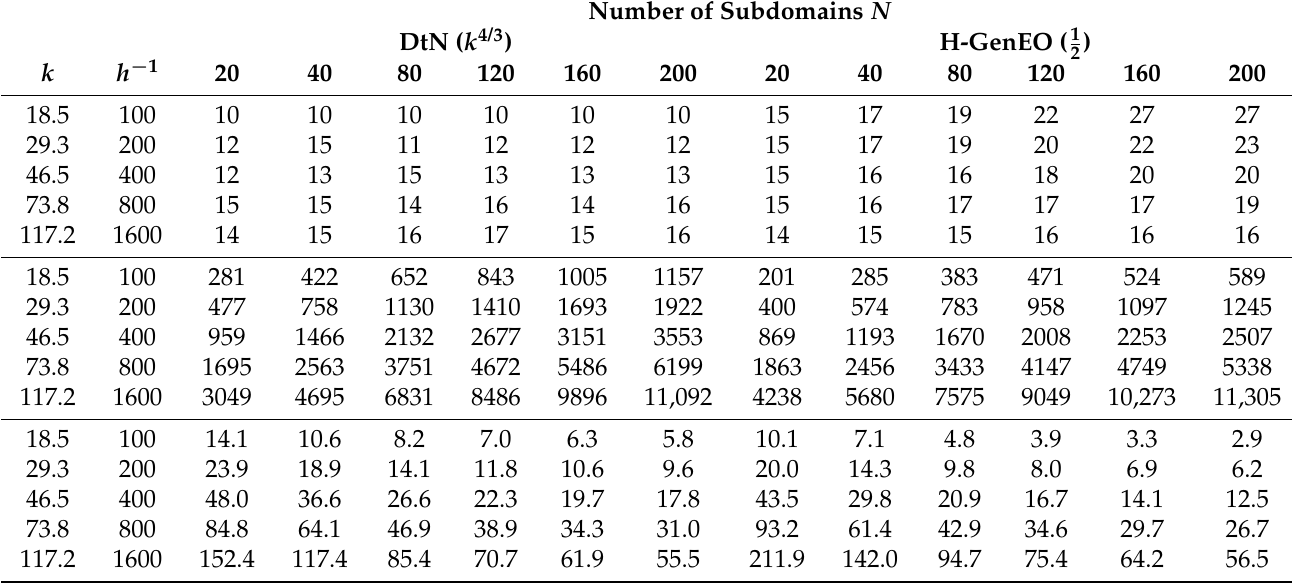
Table 4. Preconditioned GMRES iteration counts (above), size of coarse space (middle), and average number of eigenvectors taken per subdomain (below) for the homogeneous problem when using ORAS with DtN( k 4/3 ) or H-GenEO( 1 ) and a varying number of subdomains. A non-uniform 2 decomposition into N subdomains is used, given by METIS.